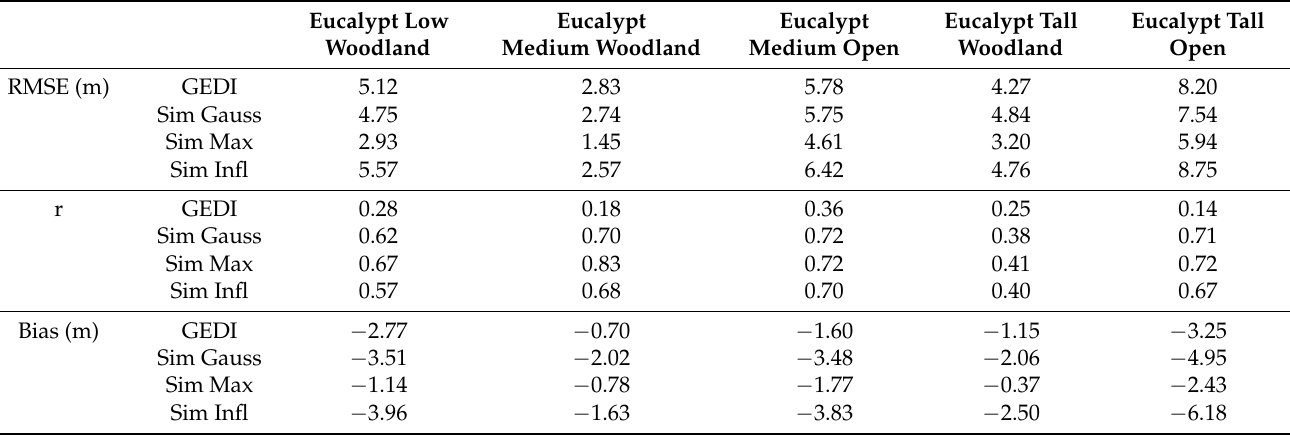
Table 5. RMSE, Pearson correlation r, and bias of real and simulated (Sim) GEDI data (RH50) in different eucalypt forest types.